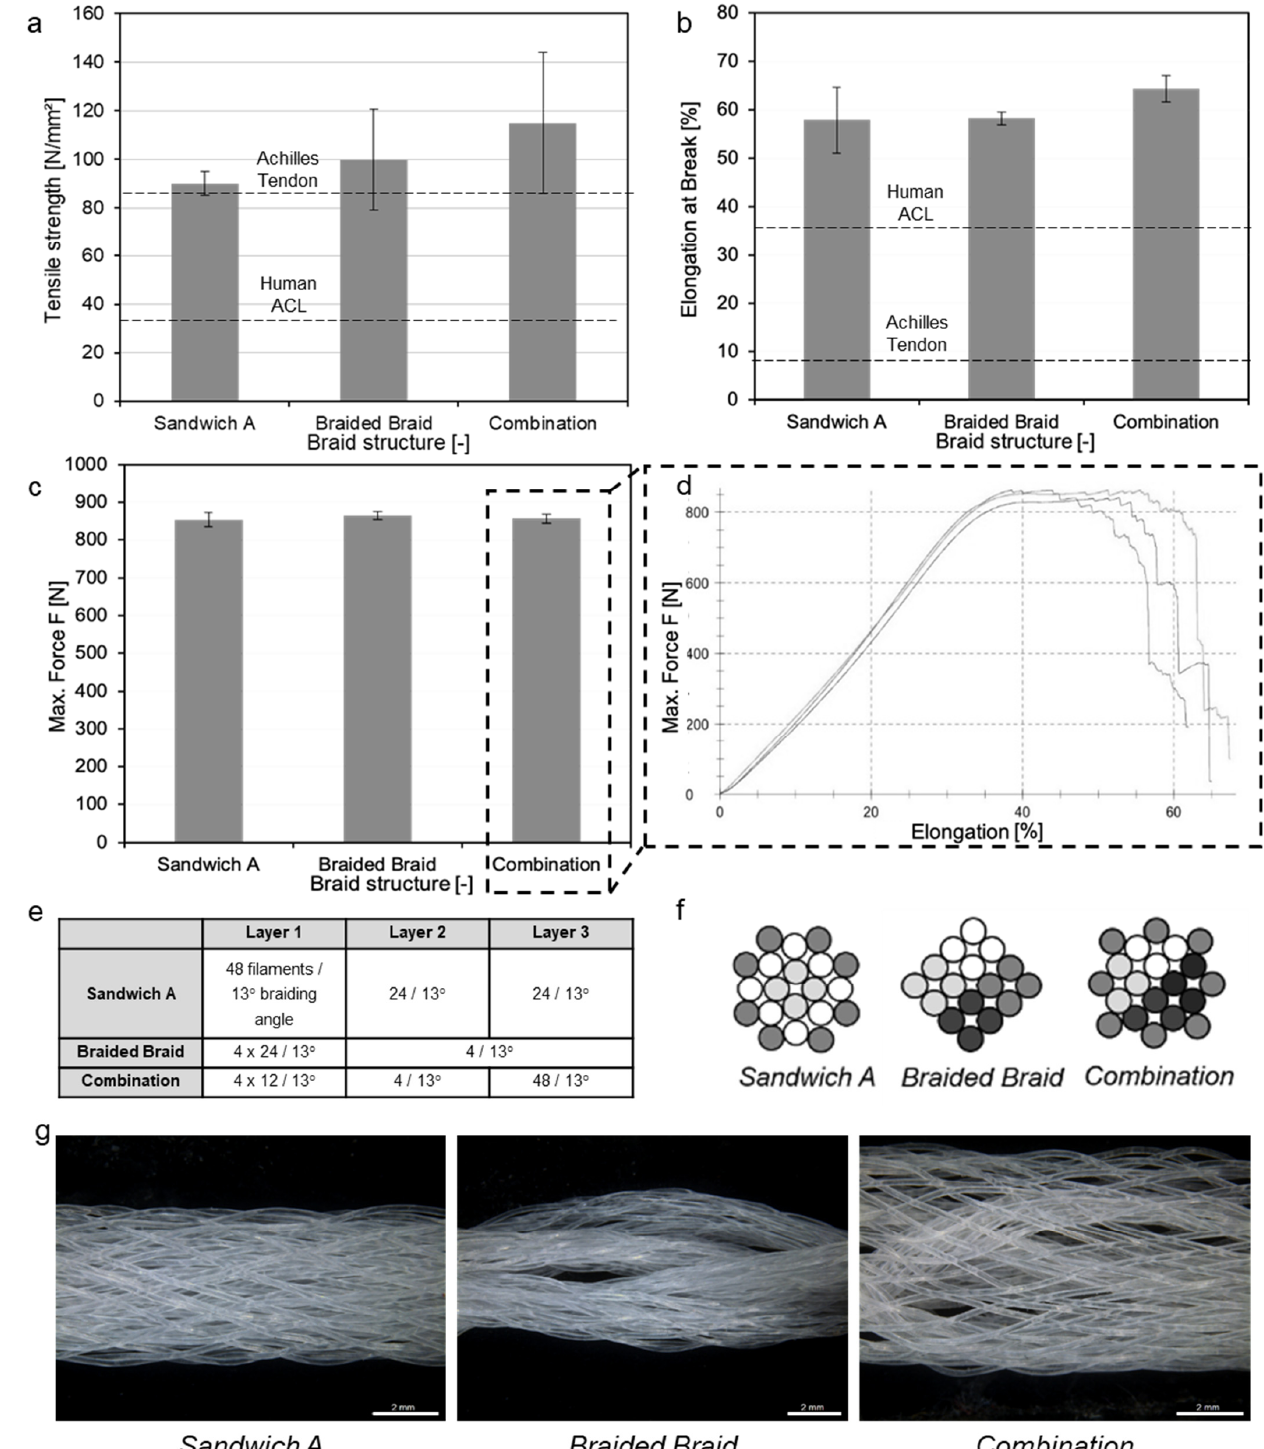
Figure 8. Mechanical characterization ( n = 3) of the three braided structures ( e – g —scale bar: 2 mm) comprising ( a ) tensile strength, ( b ) elongation at break and ( c ) max force. ( d ) An exemplary force- elongation-behavior is displayed for “Combination”. ( e ) Filament number and braiding angle of each layer. ( f ) Schematical illustration of braided structures (different gray tones indicate subse- quently braided layers (Sandwich A and Combination) or the usage of four previously braided strands (Braided Braid and Combination) and ( g ) light microscopic images of the three different braided